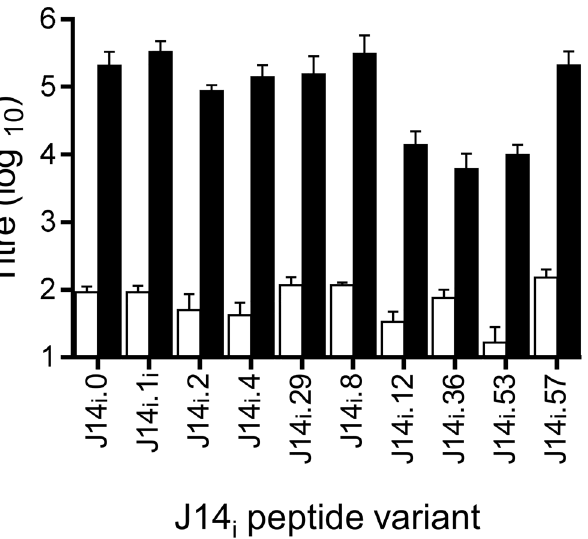
Fig 2. Peptide specific serum IgG responses of mice immunized with SV1. Data is presented as the mean ± standard deviation of ten mice per group. Anti-SV1 titers were significantly greater than anti-PBS titers for all peptides (p < 0.05). Black bars represent mean titers observed using anti-SV1 antisera. Open bars represent mean titres observed using anti-PBS